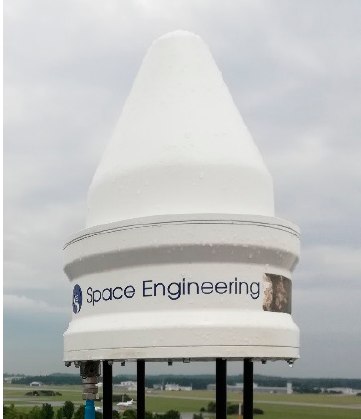
Figure 3. GalExpAnt Antenna from Space Engineering SpA, used for Galileo reference stations.